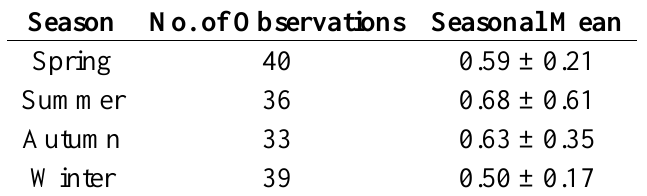
Figure 1. Frequency distribution of AOD recorded over September 2011–Augst 2012 at the Lake Taihu